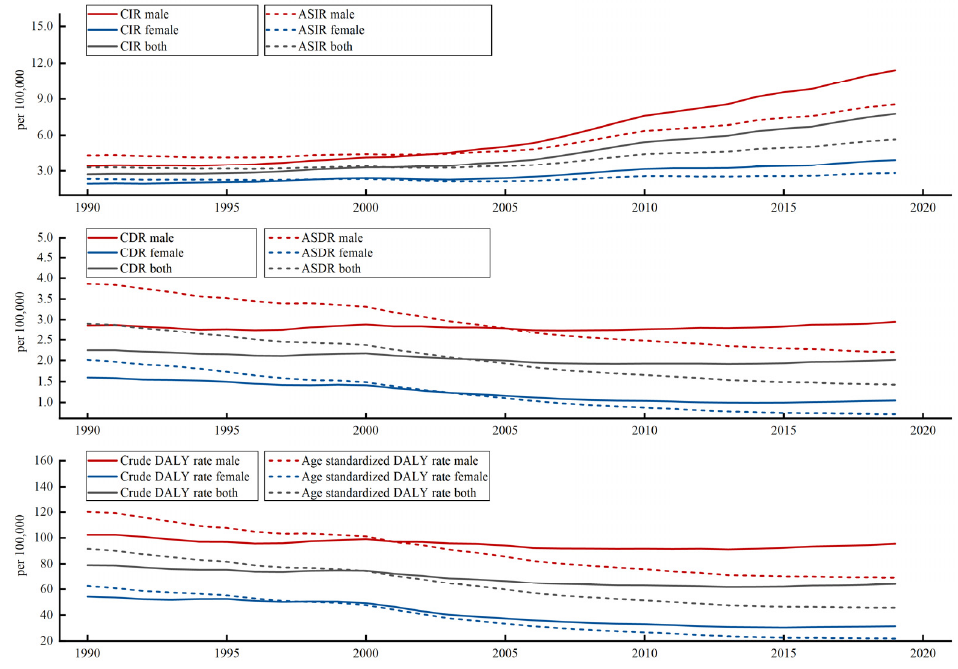
Figure 1. Trends of musculoskeletal disorders burden in China from 1990 to 2019. Different from the upward trend of CIR and ASIR, the CDR and Crude DALY rate was on a slight downward trend. For all groups, the CDR and Crude DALY rate of NPC had decreased by 10.24% and 18.86%, respectively, from 1990 to 2019. Among males, the CDR had increased by 3.12%, and the Crude DALY rate had decreased by 6.6% on the contrary. Among females, the downward trend was obvious; their CDR and Crude DALY rates had decreased by 34.26% and 42.04%. Though there was an increasing trend of ASIR of NPC, the downward trend was evident in ASDR and age-standardized DALY rate. The ASDR and age-standardized DALY rates had decreased by 50.79% and 50.26%, respectively. By gender, the decline of ASDR and age-standardized DALY rate was more pronounced in females than in males. The ASDR had decreased by 43.11% for males and 64.37% for females. Paying attention to the age-standardized DALY rate, we found that males had decreased to 42.17% and females had decreased to 64.81%.